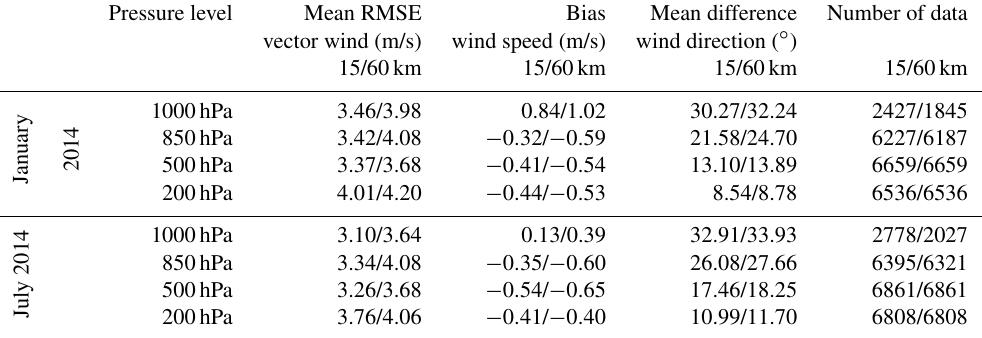
Table 3. The statistics of MPAS-A simulated horizontal wind validated at radiosonde stations located in North America. In each cell, the first value is from the 60–15km variable-resolution grid simulation (labeled as 15km) and the second is from the 60km uniform grid simulation (labeled as 60km). Note that the number of data at 850 and 1000hPa is different between the two simulations because of the differences in their grids’